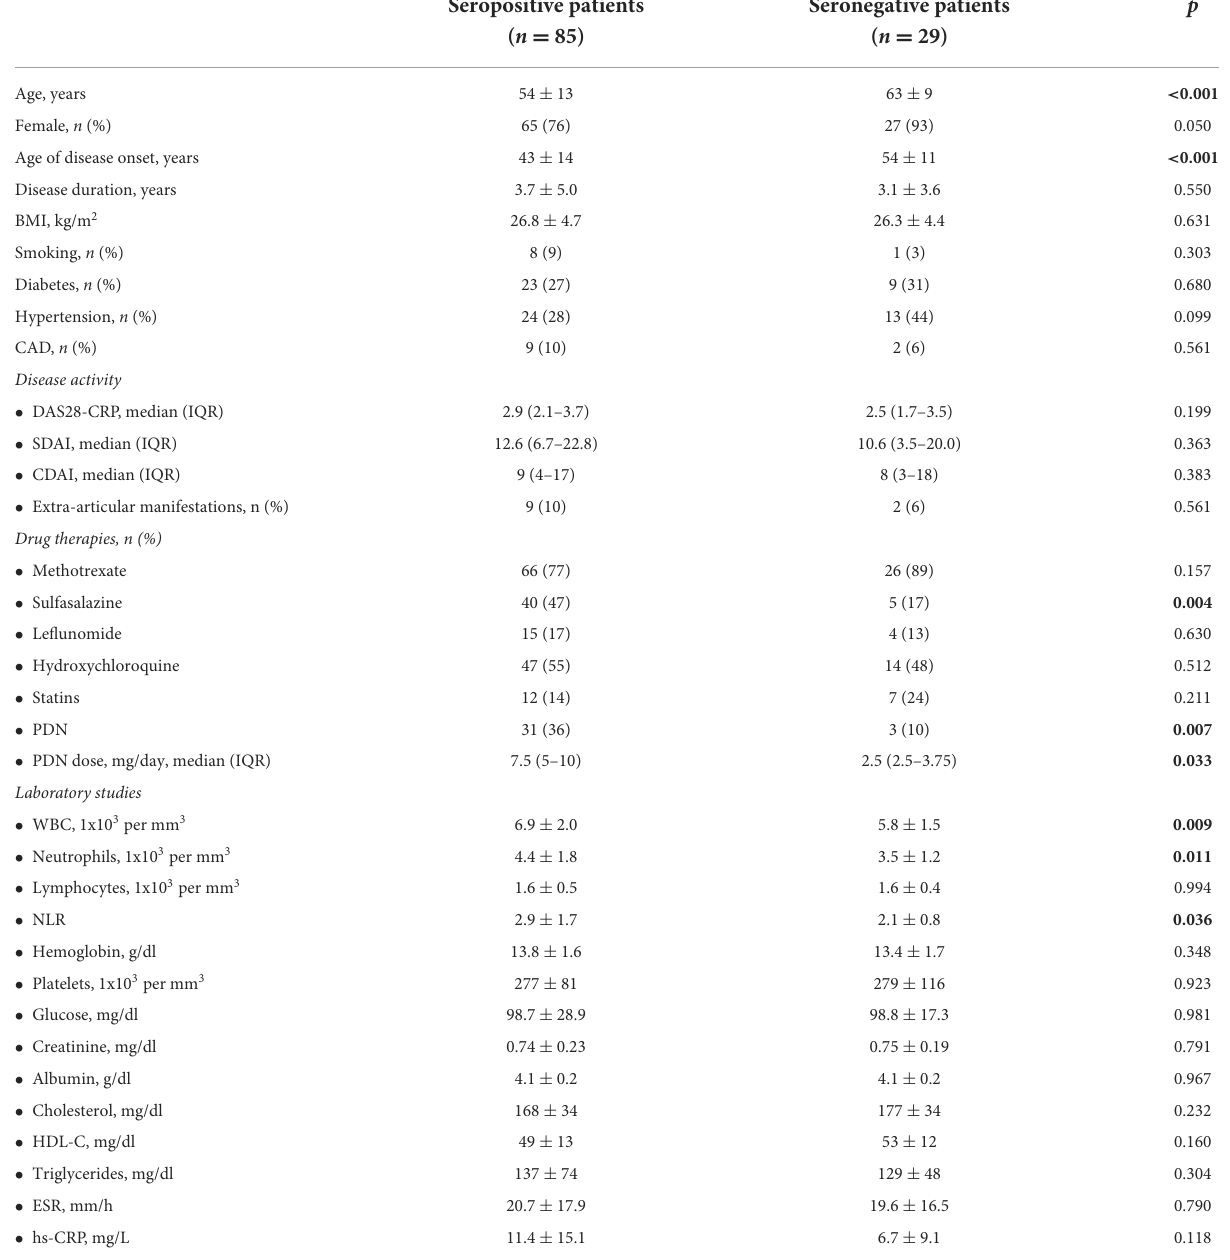
TABLE 1 Clinical and laboratory features of patients with rheumatoid arthritis.